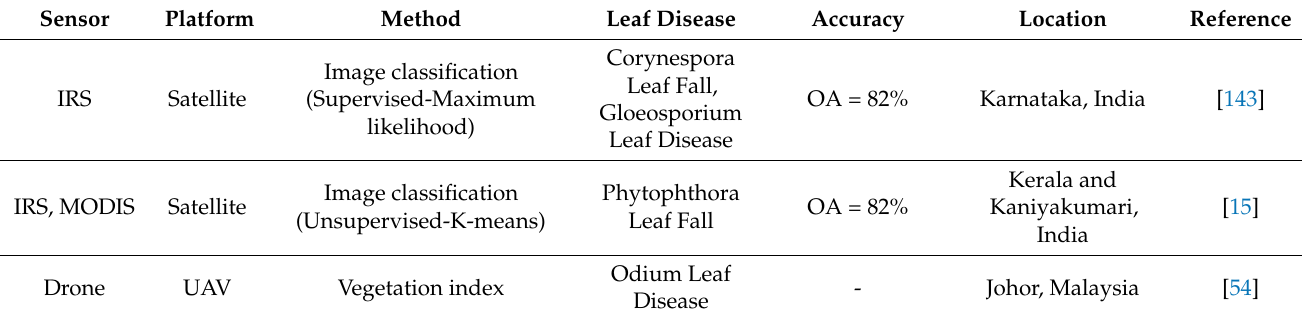
Table 9. Comparison of selected parameters on studies conducted to detect rubber tree diseases. Sensor